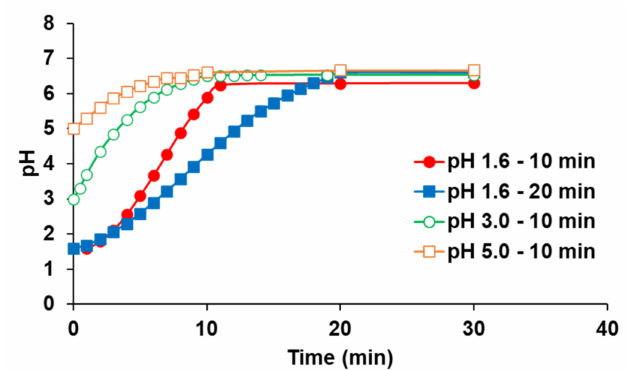
Figure 3. Time profile of the fluid pH in the donor chamber of the BE